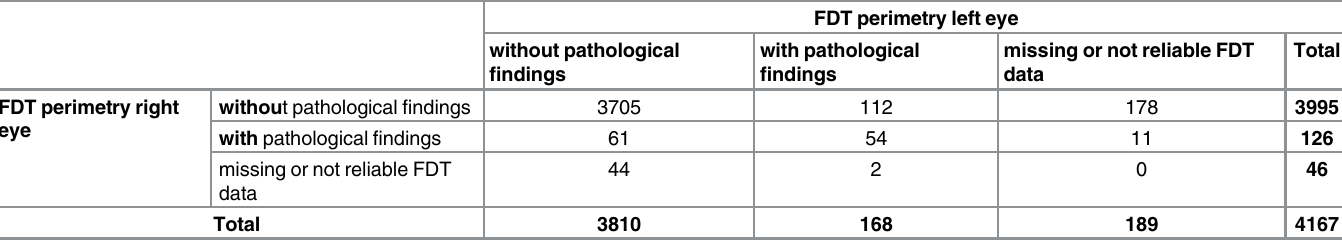
Table 4. Cross-classified table for all FDT results (n = 4167).